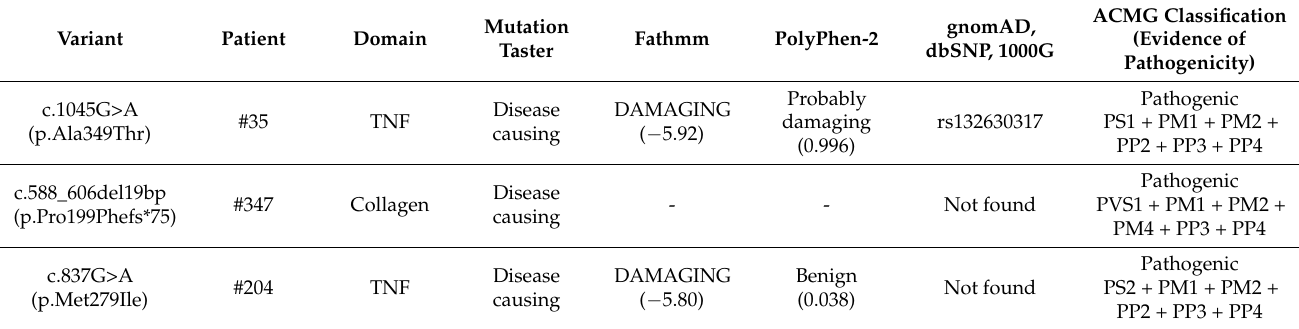
Table 2. Pathogenic prediction of the EDA